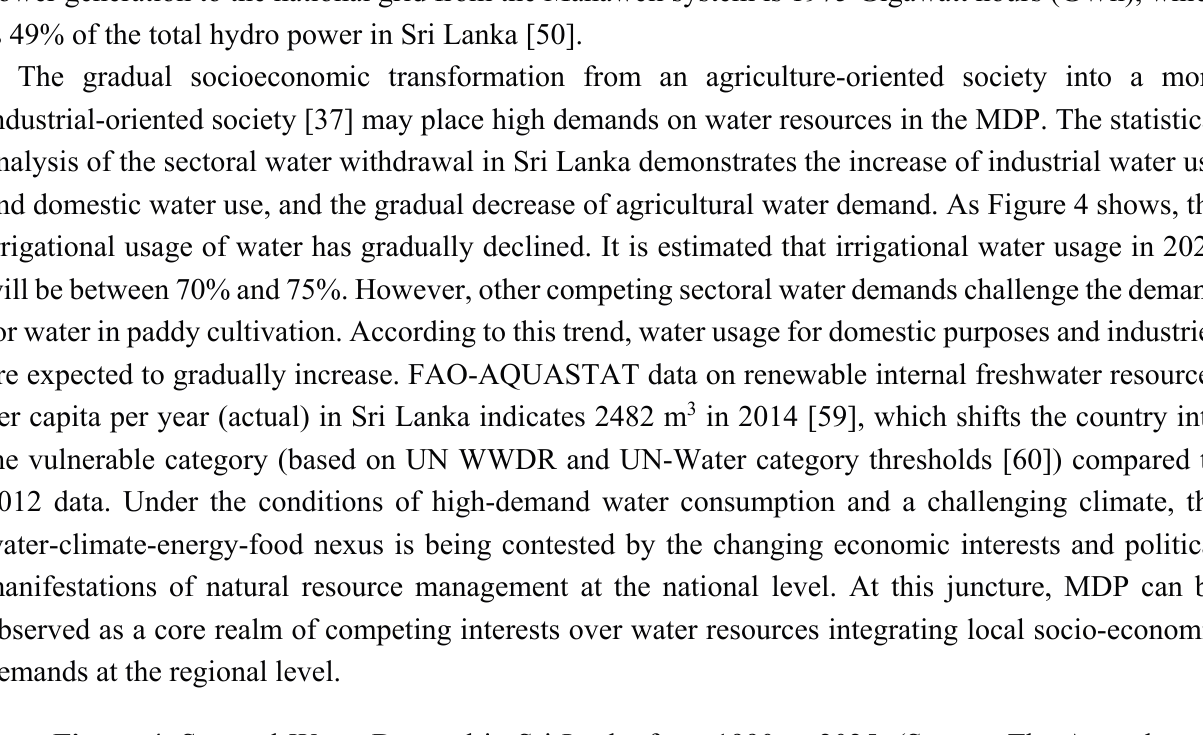
Figure 4. Sectoral Water Demand in Sri Lanka from 1990 to 2025. (Source: The Annual Report—Economic perspective Sri Lanka